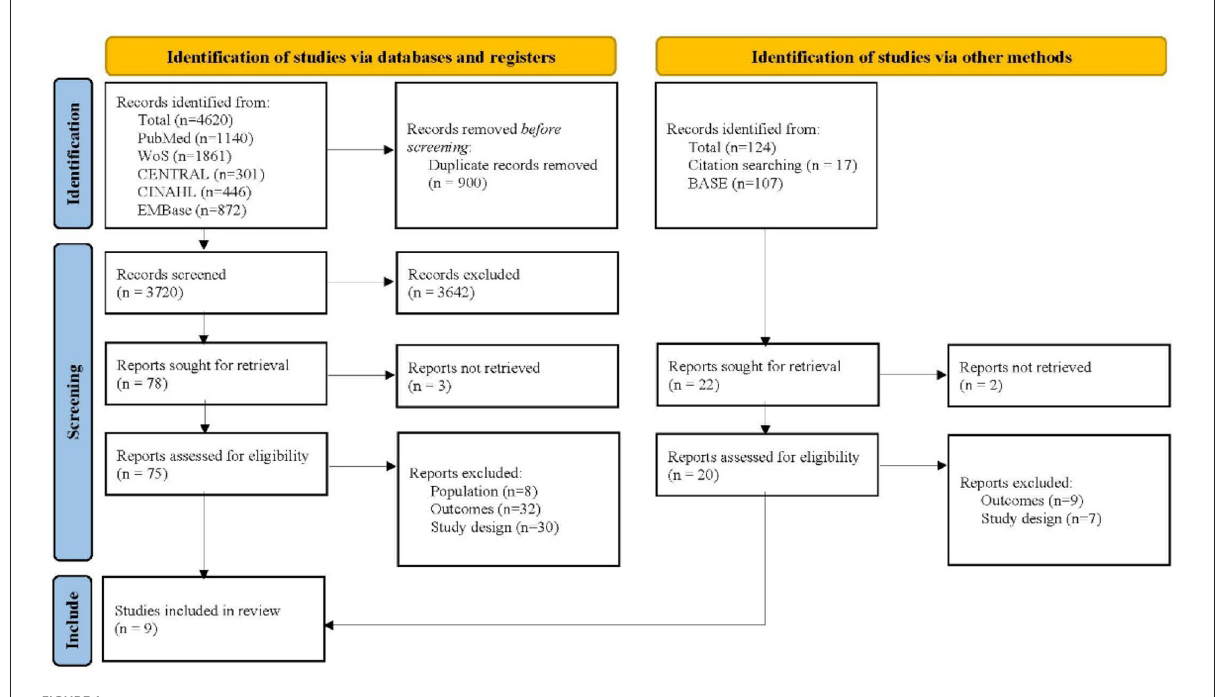
FIGURE1 Flowchart of study